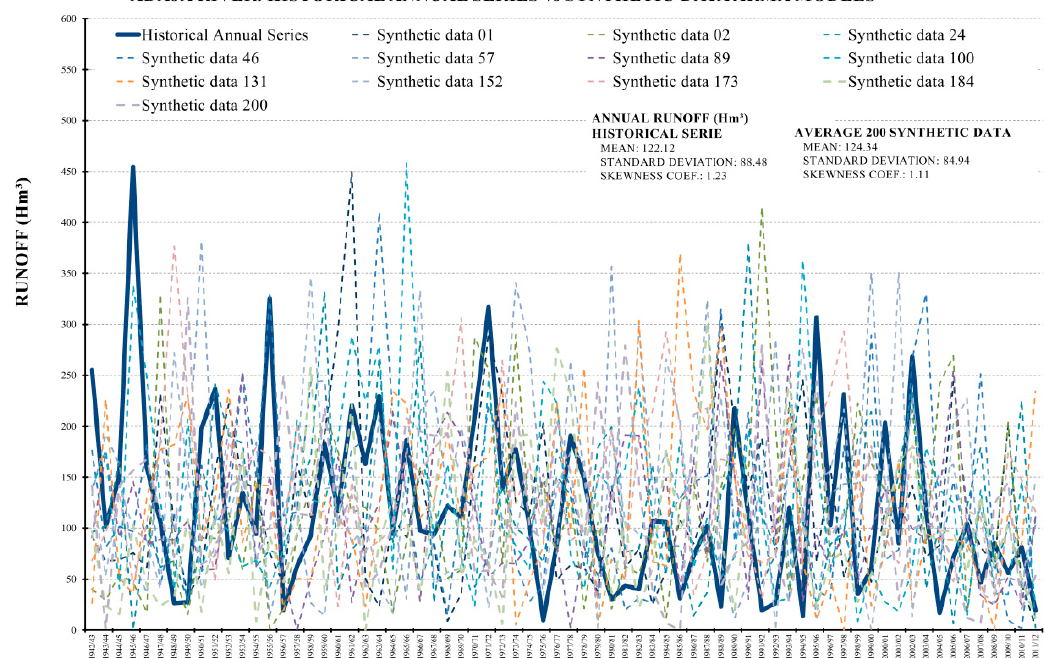
Figure 5. Adaja case study. Comparison of annual runoff synthetic series vs. historical record.